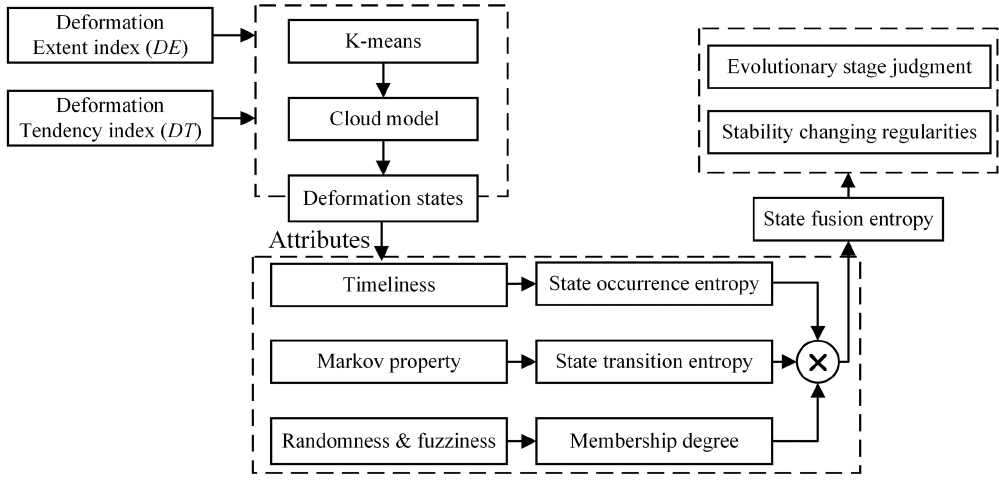
Figure 1. Flow chart of state fusion entropy method.